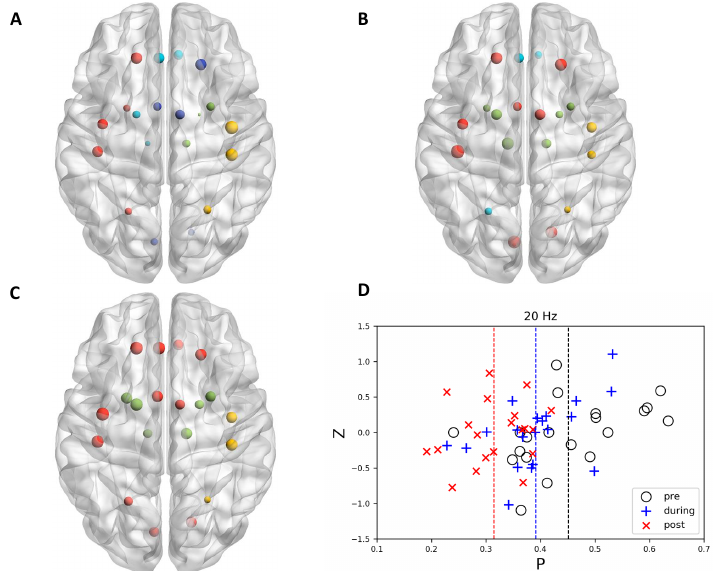
Figure 4. The node topology and community structure of 20 Hz stimulation in motor-related regions at ( A ) pre, ( B ) during, and ( C ) post time points. Left orientation represents left side of the brain. Panel ( D ) illustrated P - z plot for 20 Hz stimulation.